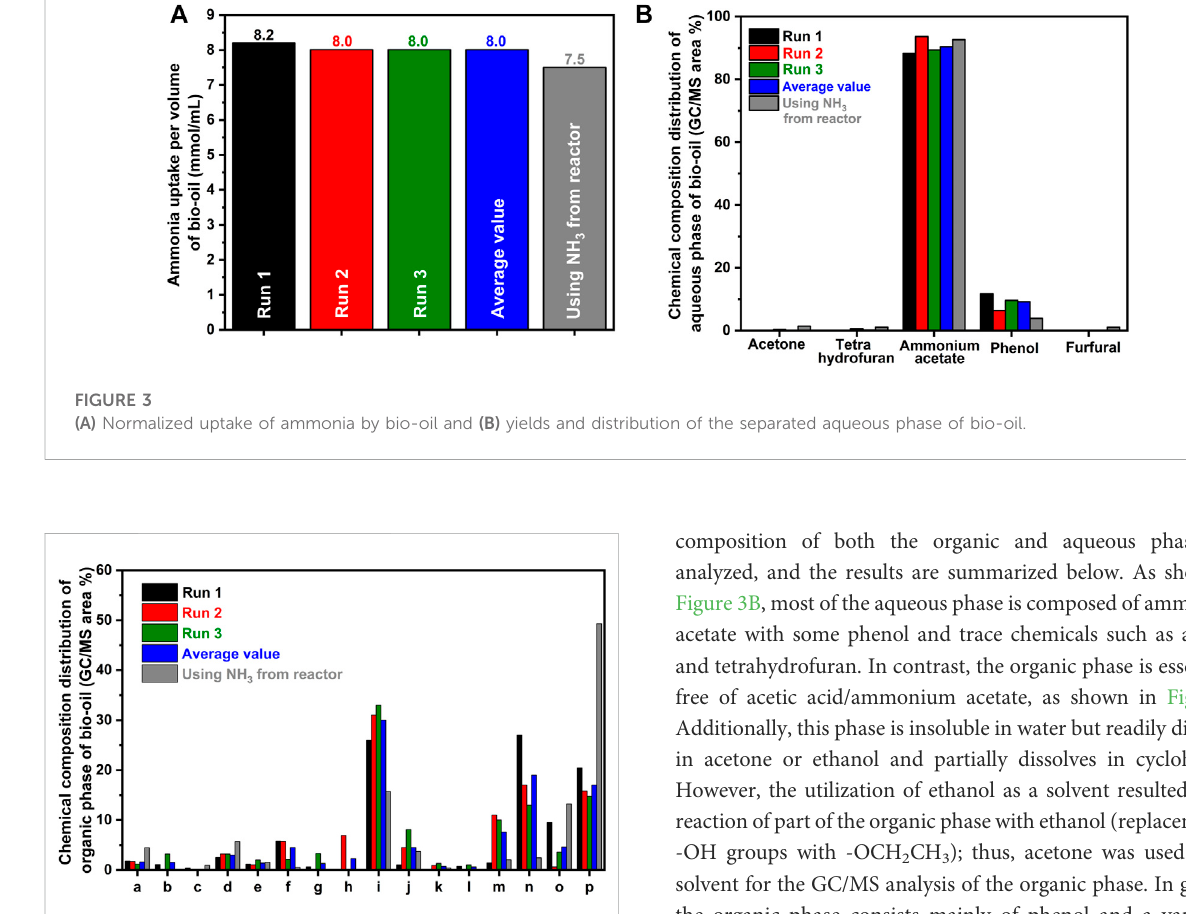
FIGURE 4 Yields and distribution of the quanti fi ed species in the separated organic phase of bio-oil. (A) tetrahydrofuran (B) acetic acid/ammonium acetate (C) ethylbenzene (D) O-xylene (E) furfural (F) 1H-pyrrole-2-carboxaldehyde (G) aziridine, 2- isopropyl-1,3-dimethyl-, trans- (H) 4-piperidinone, 2,2,6,6- tetramethyl-, oxime (I) phenol (J) tricyclo [3.3.1.1 (3,7)]decan-1- amine (K) acetamide, N-(3H-[1,2,3]triazolo [4,5-day]pyrimidin-7- yl)- (L) 1H-pyrrole, 1-(2-furanylmethyl)- (M) 2-methyl-2- azatricyclo [4.3.1.0 (3,8)] decane (N) pyrazolo